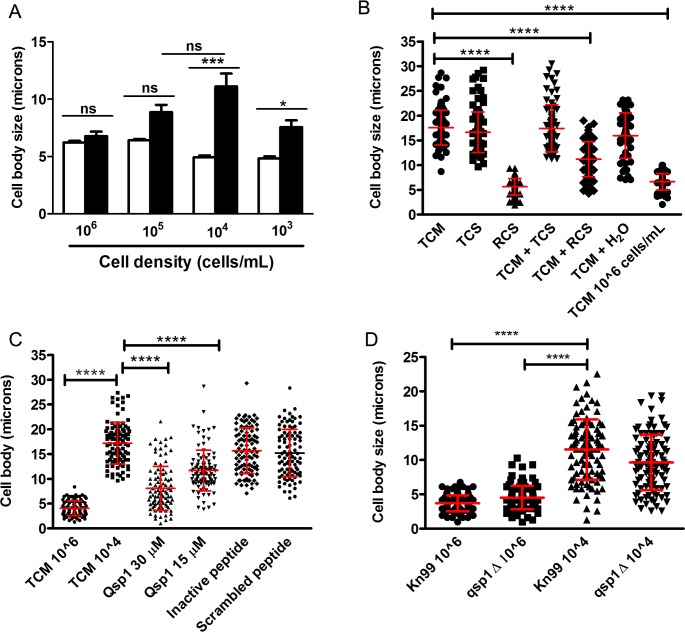
Influence of cell density on titan-like cell formation in C. neoformans.(A). Cells from H99 strain inoculated in Sabouraud (white bars) or TCM (black bars) at different concentrations (103, 104, 105 and 106 cells/mL) in 96-well plates. Cell body size was measured after incubation overnight at 37°C with CO2. The asterisks indicate significant differences. B) Effect of conditioned media on cell body size. Cells from H99 strain were incubated in different conditioned TCM medium denominated (see material and methods) as TCS (supernatant of titan-like cells TCM cultures), RCS (supernatant of regular size TCM cultures), TCM + TCS (a 1:1 mixture of fresh TCM with TCS), TCM + RCS (a 1:1 mixture of fresh TCM with RCS). As controls we used a diluted TCM in H2O (1:1) and fresh TCM inoculated with 104 cells/mL (TCM) and with 106 cells/mL. (C) Cells from H99 strain were grown in TCM supplemented with 30 uM and 15 uM of the quorum sensing peptide Qsp1 (NFGAPGGAYPW). As controls, TCM supplemented with 30 uM of an inactive Qsp1 (NFGAPGAAYPW), with 30 uM of a scrambled Qsp1 peptide (AWAGYFPGPNG). TCM without any supplementation was used as control. Cell body size was measured after overnight incubation at 37°C with 5% CO2. D) Titan-like cell formation of qsp1 mutant. Cells from the KN99 (wild type) and qsp1 mutant were inoculated in TCM at 104 and 106 cells/mL, and cell body size was determined after 18 h of incubation at 37°C in the presence of 5% CO2.